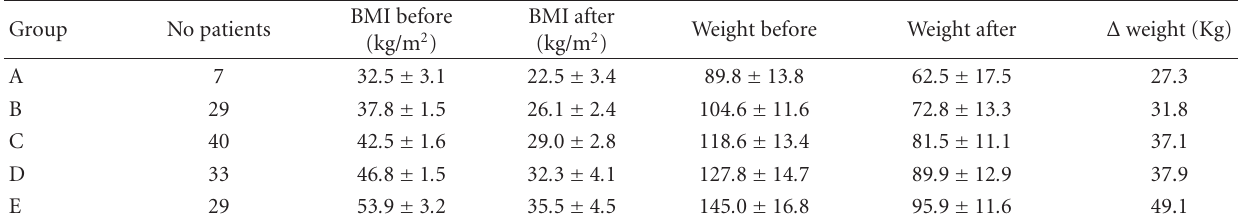
Table 1: BMI and weight before and after 12 months.